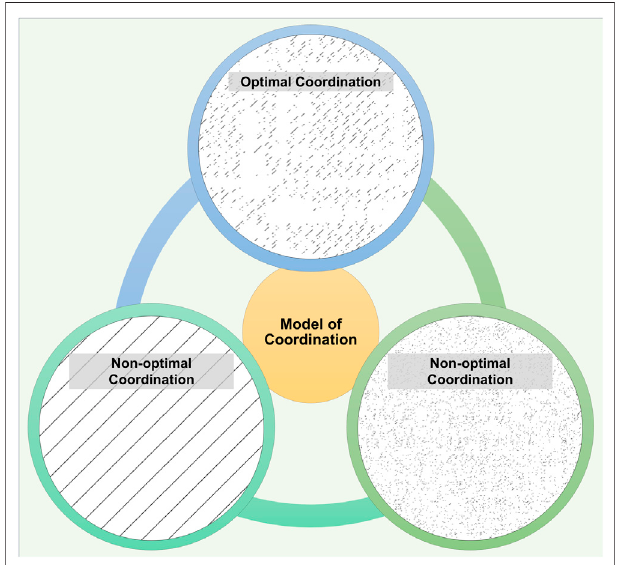
FIGURE 1 | The model of inter-limb coordination. In this model, healthy inter-limb coordination sits at a sweet-spot between patterns that exhibit either metronomic qualities or random-like qualities. Healthy individuals demonstrate optimal coordination (top) where the cross recurrence plot shows an intermediate level of diagonal lines (representative recurrence plot from the control group). Diagonal lines indicate the length of time that the right and leftlimbsarecoordinated.Longeror shorterdiagonallinesindicate anon- optimal coordinated behavior (bottom left and right). Bottom left shows the recurrence plot with two simulated sinusoidal time series and long diagonal lines, as would be seen in perfectly coordinated gait. Bottom right shows the opposite, an uncoordinated pattern of two simulated random time series with negligible diagonal